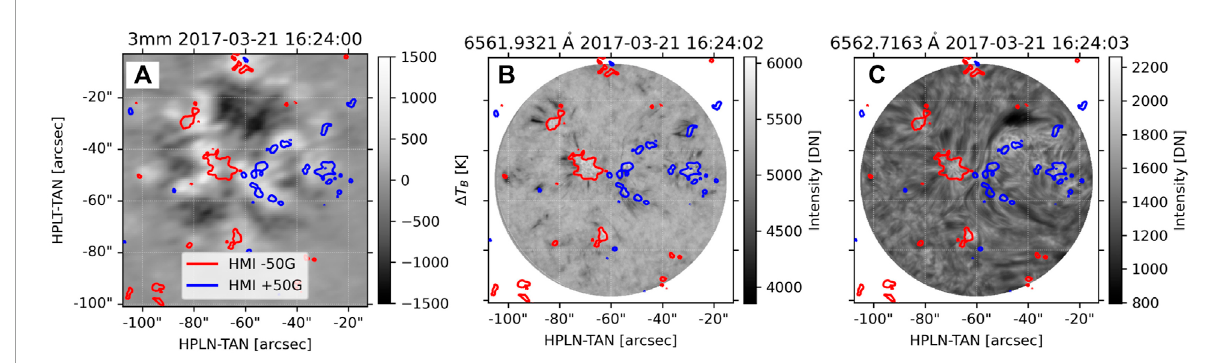
widthathalfmax,butmodifiedtoisolateonlythechromospheric portion of the line profile around the line core. First, we construct a spline-interpolated model (green dashed line) of the measured line profile (blue “+” symbols and straight lines). We define the center wavelength as the center of the best-fit Gaussian (orange) to the central 12 measured points. The intensity minimum (red cross; I ) is the value of the spline model at the center min wavelength. Next we define an upper threshold as the average intensity at ±. 75 Å from the line center (marked by the green and purple dots) using the spline model. The intensity midpoint betweentheupperthresholdandtheminimumismarkedineach wing of the line by the red stars. The final width δλ is the distance between them calculated using the spline model, shown as the red dashed line.